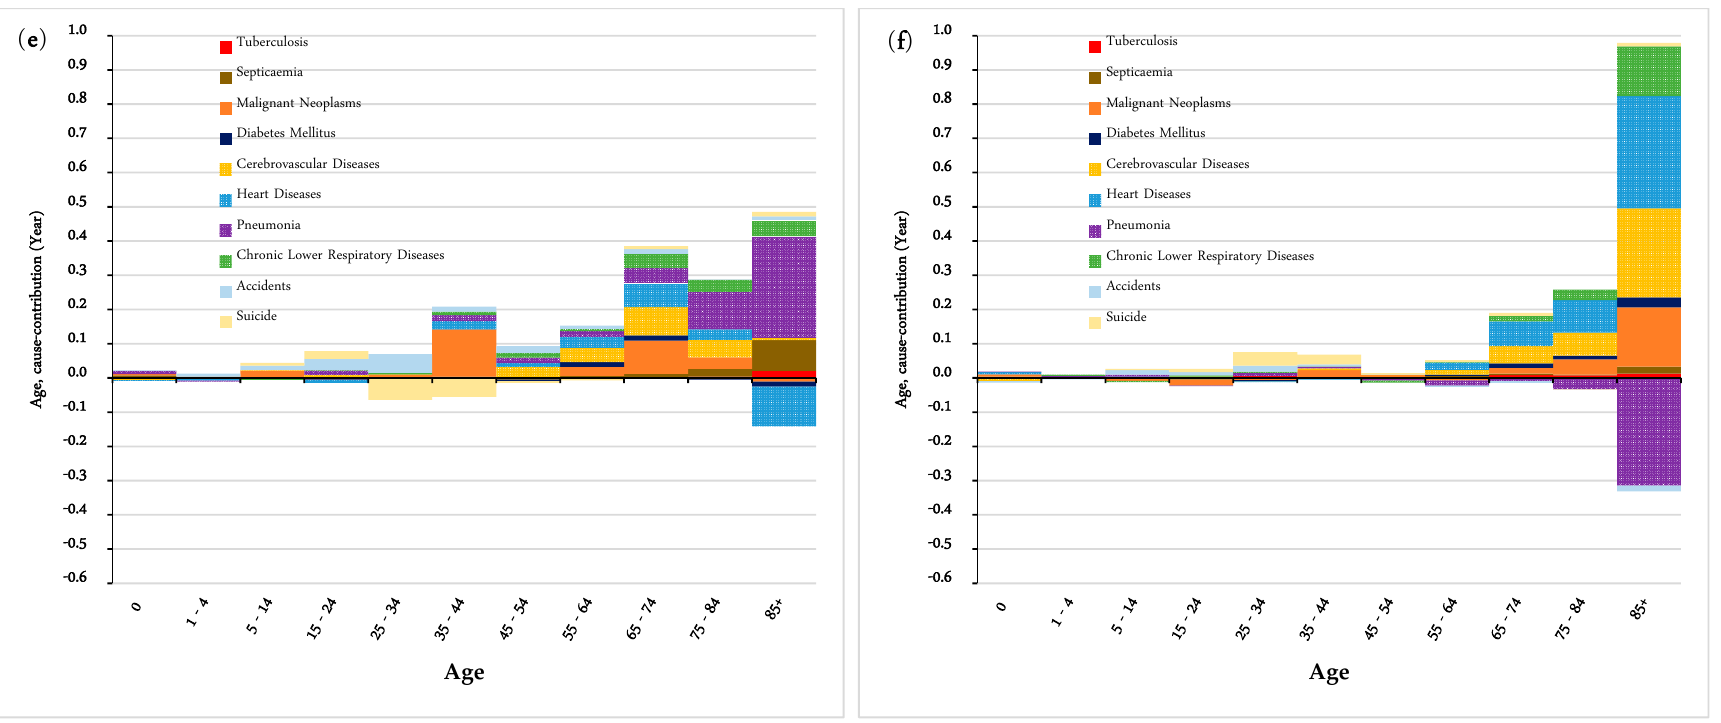
Figure 2. Arriaga’s decomposition of the change in life expectancy by age group and major causes of death in 1986–2015 in Hong Kong: ( a ) Contributions by males in 1986–1995; ( b ) Contributions by males in 1996–2005; ( c ) Contributions by males in 2006–2015; ( d ) Contributions by females in 1986–1995; ( e ) Contributions by females in 1996–2005; and ( f ) Contributions by females in 2006–2015